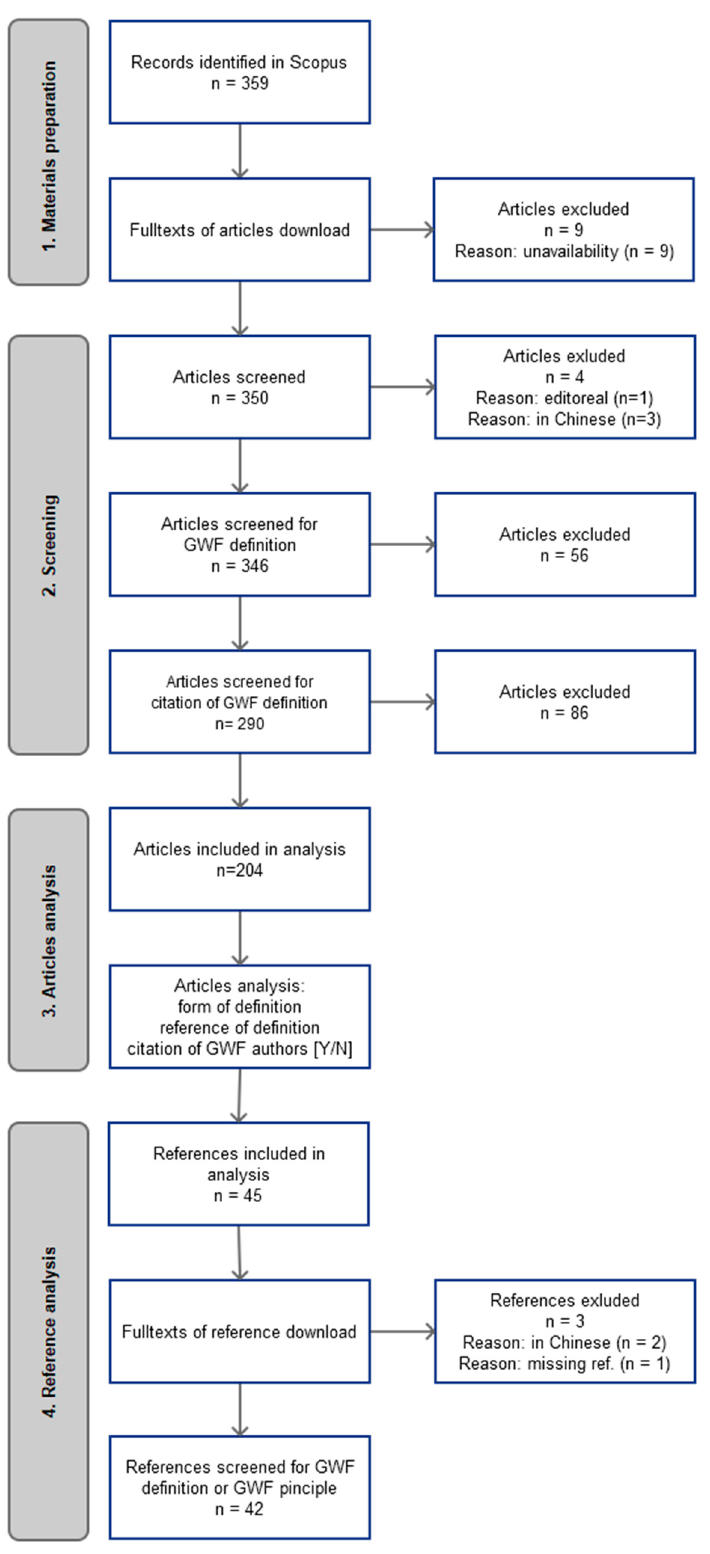
Figure 1. Methodological scheme for analysis.